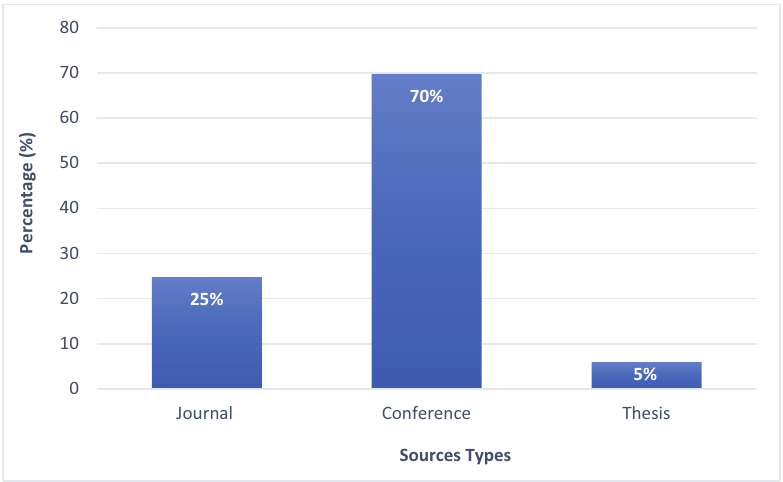
Figure 3. Percentage of publications associated with different surveyed sources in this survey.